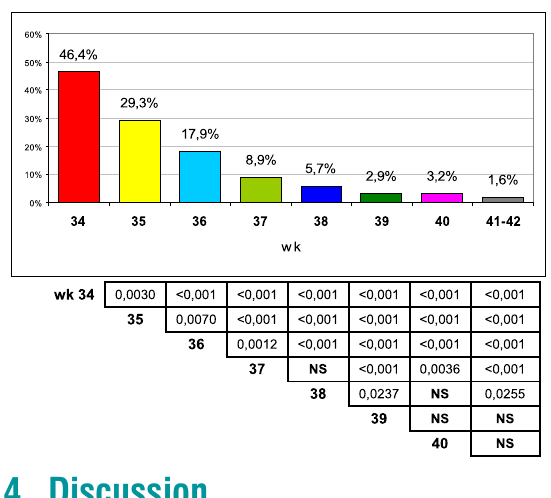
Figure 5. Frequency of respiratory distress syndrom in late pre- term and term infants deliveried by cesarean section and statistically